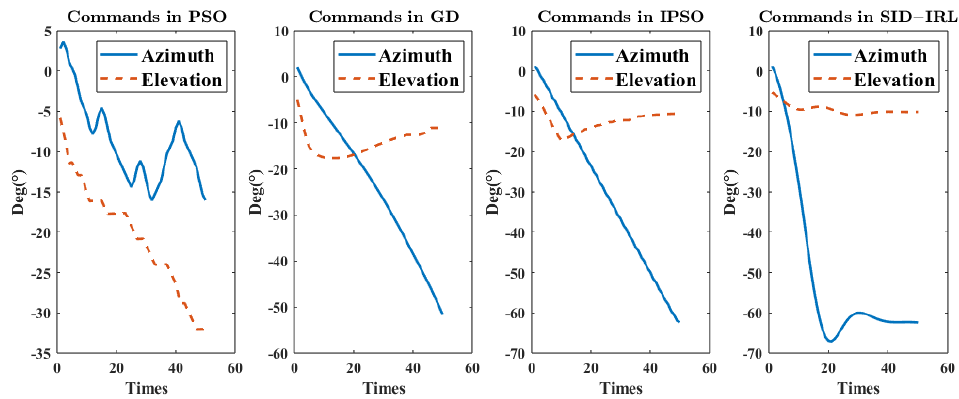
Figure 18. Command of the projectile angles in case 2.